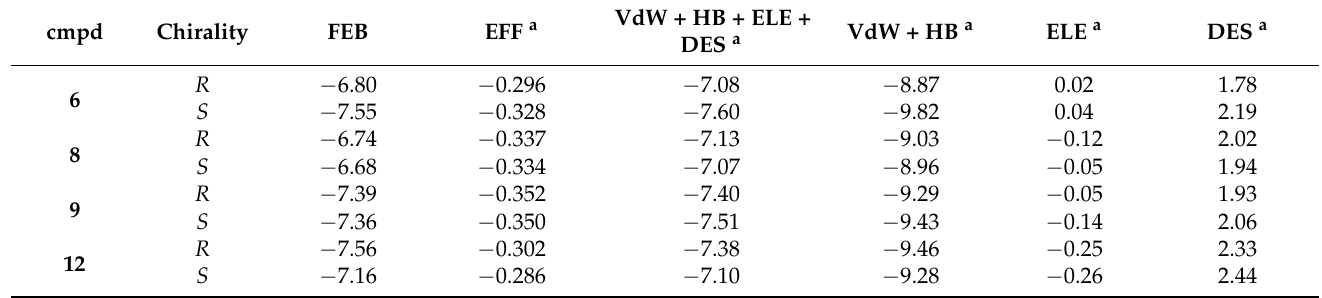
Table 3. Free energy of binding (FEB) and relative contributions a estimated from docking